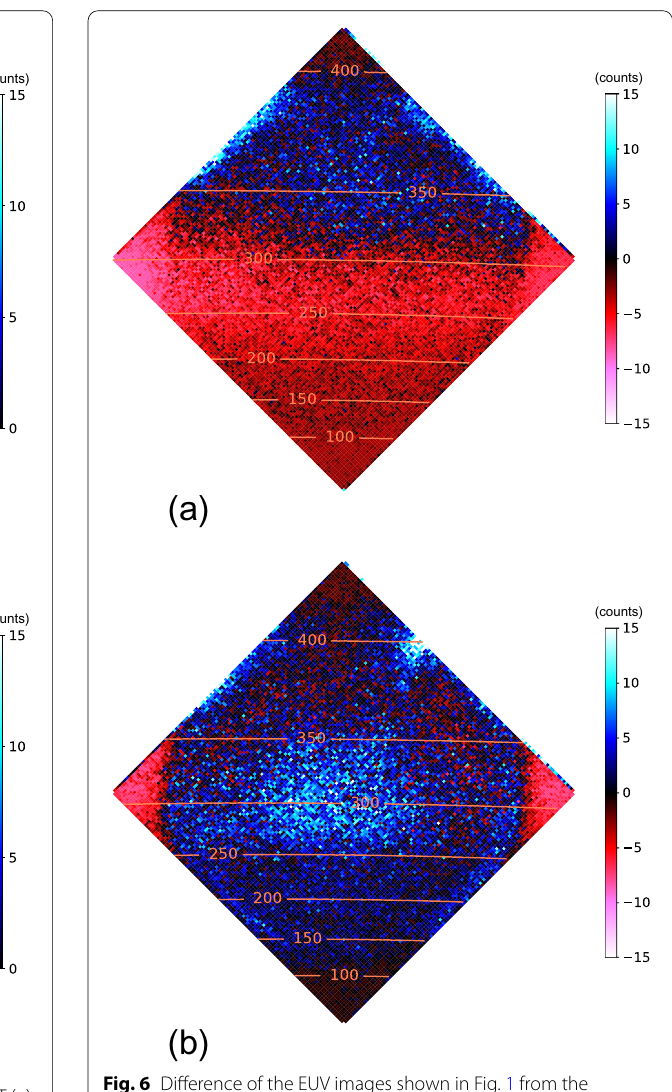
Fig. 5 Simulated images of 91.1 nm EUV for EUVI-B at 21:08:56 UT ( a ) and 21:19:08 UT ( b ) on December 26, 2012